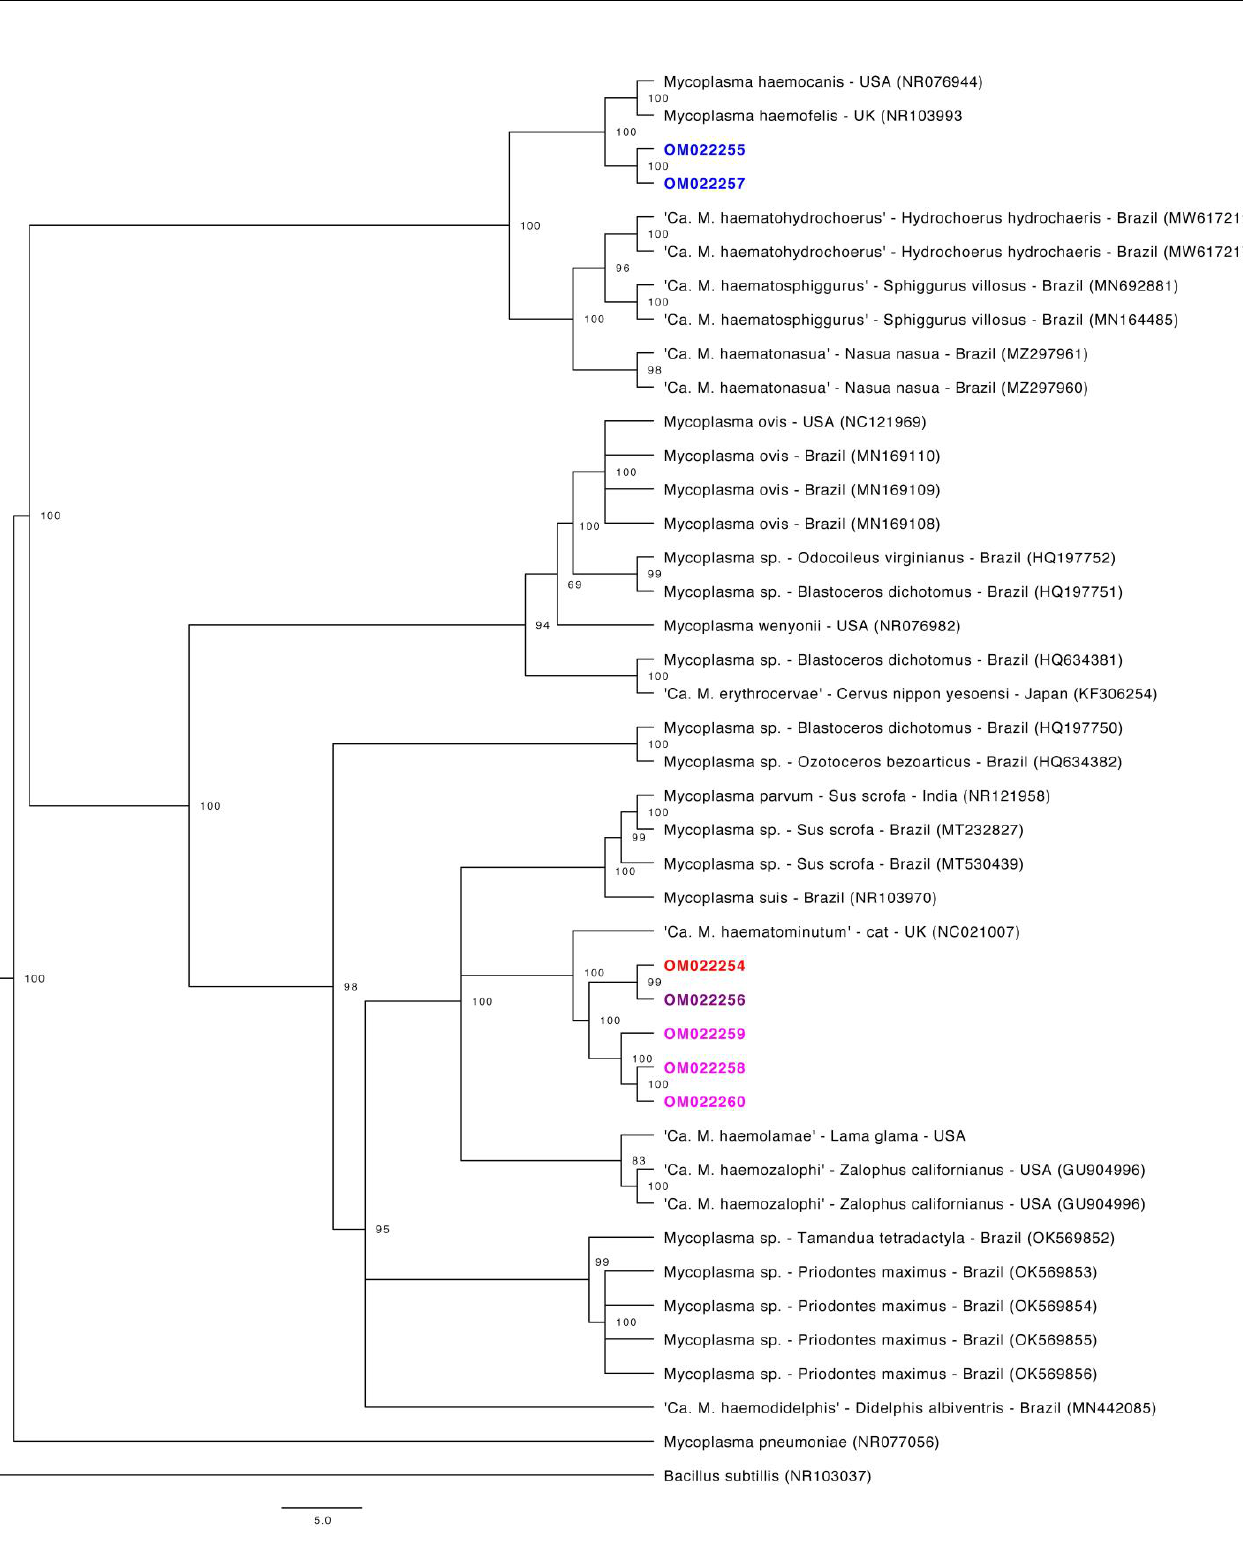
Figure 2. Phylogenetic tree based on partial 23S rRNA gene fragments of Mycoplasma sp. Tree was constructed by Bayesian Inference and a sequence from Bacillus subtillis (NR103037) was used as outgroup. Sequences obtained in the present study are highlighted in colors: sequences that fit in Ca1 by the 16S rRNa phylogeny are highlighted in purple, pink and red colors. Sequences that fit in Ca2 by the 16S rRNA phylogeny are highlighted in blue.